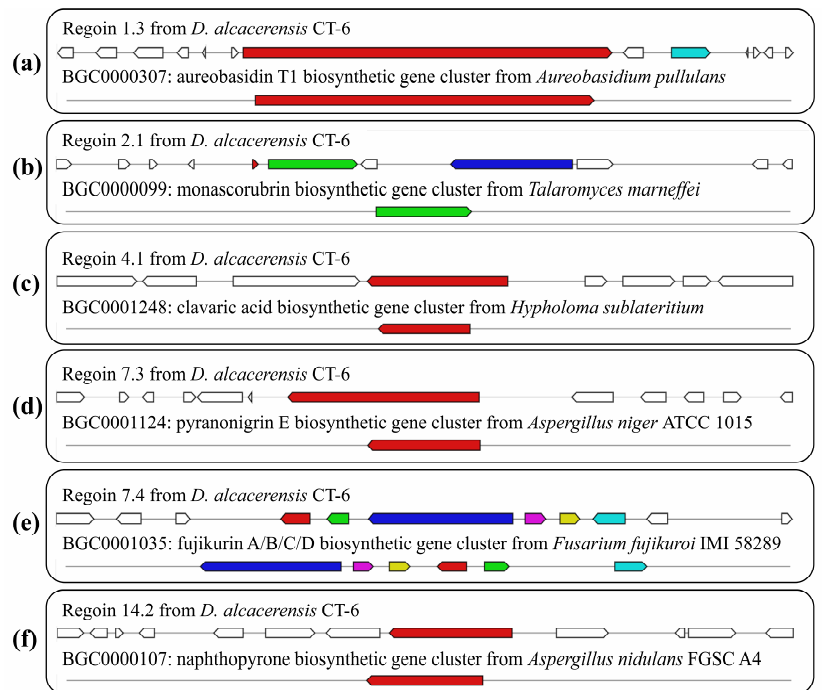
Figure 8. Schematic representation of D. alcacerensis CT-6 putative BGCs showing high similarity (100%) with genes from characterized BGCs: aureobasidin T1 ( a ), monascorubrin ( b ), clavaric acid ( c ), pyranonigrin E ( d ), fujikurin A/B/C/D ( e ) and naphthopyrone ( f ). The upper part represents the BGC in D. alcacerensis CT-6, followed by the known BGCs in the MIBiG database.